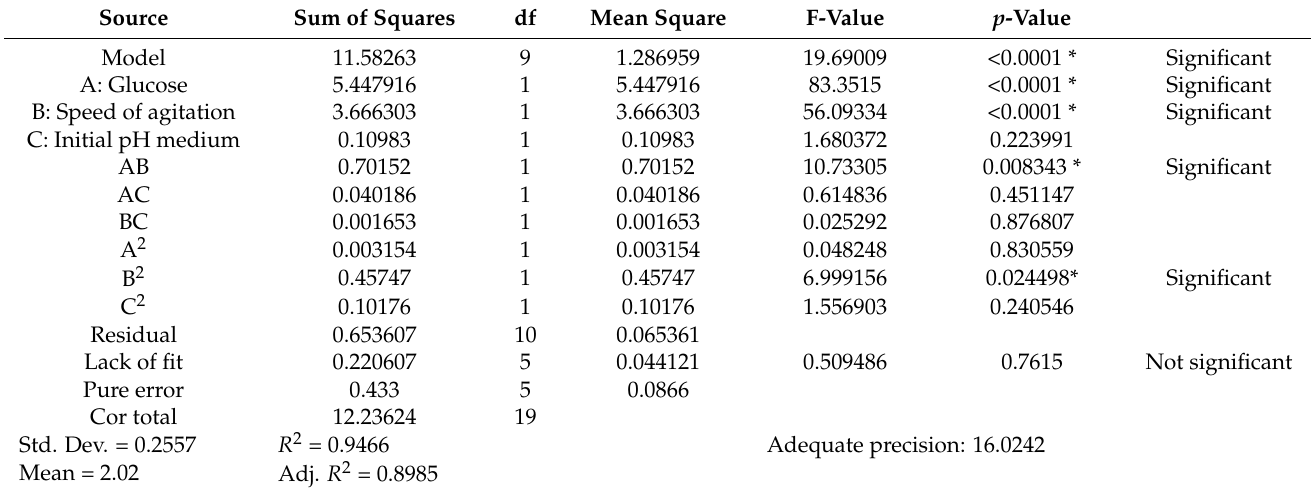
Table 4. The results of analysis of variance (ANOVA) generated from the CCD quadratic model for